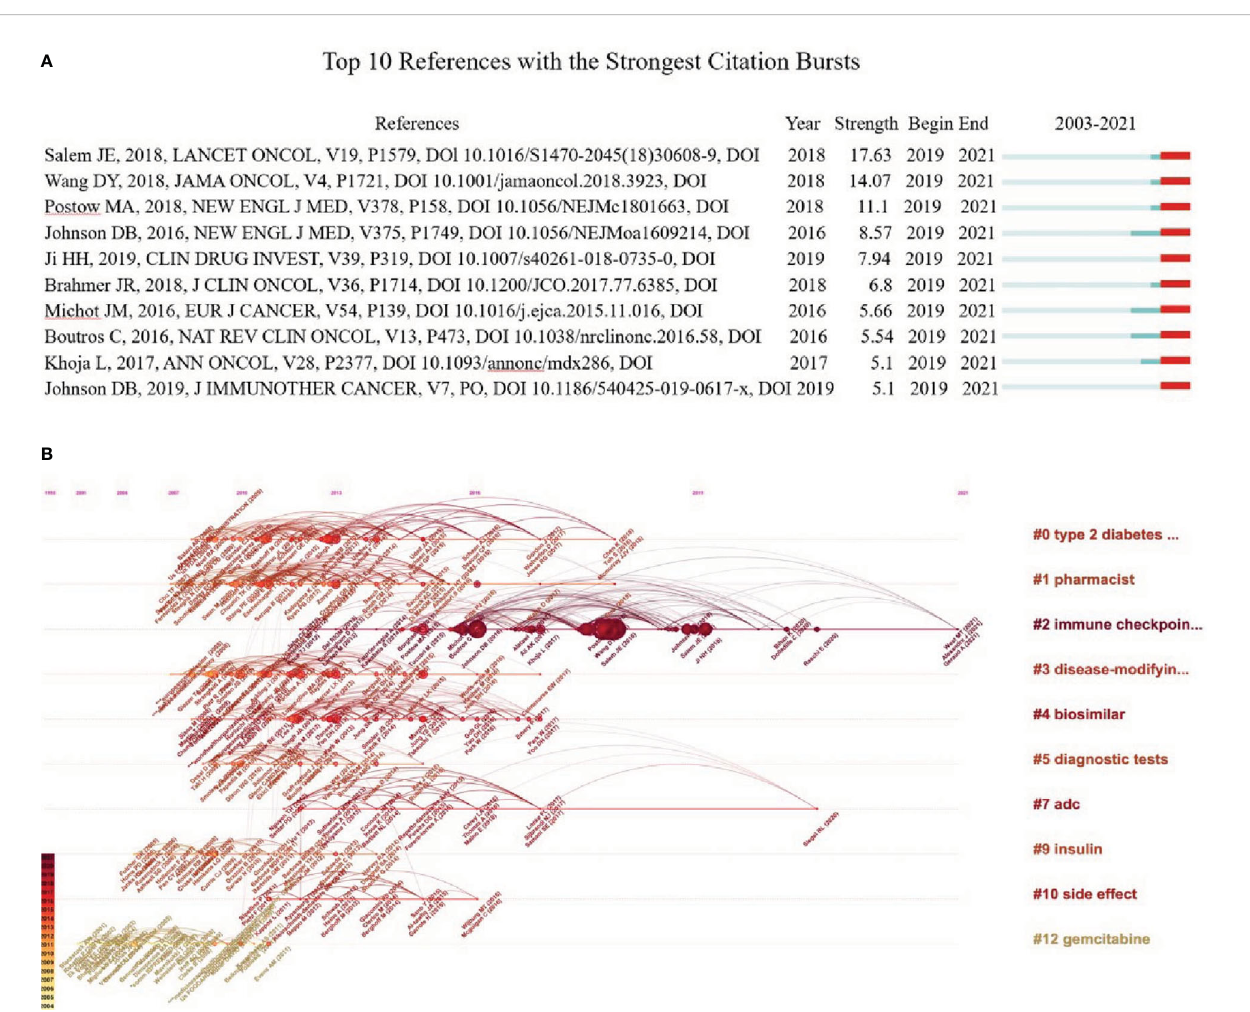
FIGURE 9 Co-citation analysis. (A) Analysis of the top 10 co-cited bursts. The blue line indicates the timeline from 2002 to 2021, and the red line indicates the point in time when each burst was co-cited. (B) Visual map of the timeline viewer associated with pharmacovigilance and cancer. The cluster tag sits at the far right end of each horizontal line. The node size on the line is proportional to the referenced quantity. The time at the top of the fi gure corresponds to the paper ’ s publication date. Nodes with darker labels re fl ect more recent literature, and nodes with more links indicate